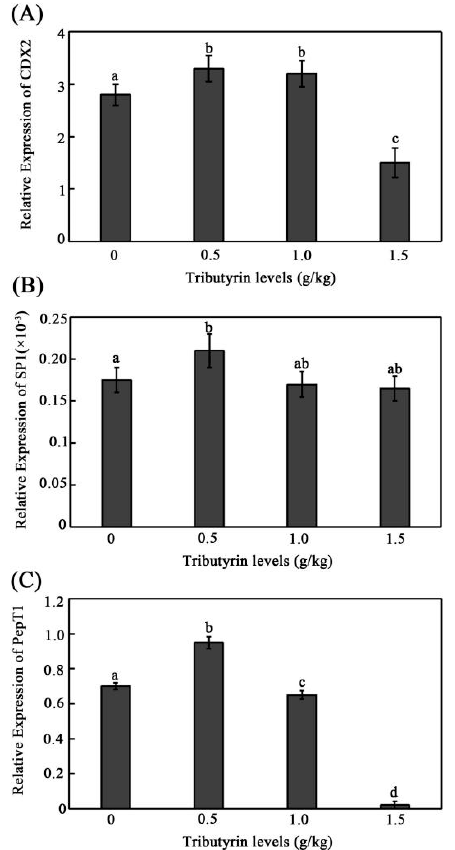
Figure 1. Effect of different levels of tributyrin supplementation in feed on the mRNA expression levels of grass carp intestinal genes. ( A – C ) The mRNA expression of grass carp intestinal genes CDX2 ( A ), SP1 ( B ) and PepT1 ( C ). The data represent the mean ± SD. Tukey’s multiple range test was performed, and different letters represent significant differences ( p < 0.05, n = 4 for each treatment with a total of 12 fish).